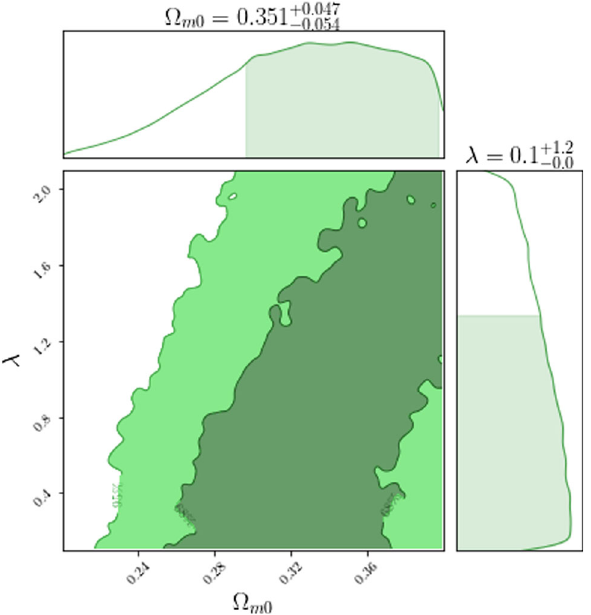
Fig. 8 MCMC simulations for the f ( R ) model with n = 2, consid- ering joint analyses of the H ( z ) and [ f σ 8 ] ( z ) data and the flat priors: λ − 1 = [ 0 . 1 , 2 . 0 ] and Ω = [ 0 . 15 , 0 . 4 m 0